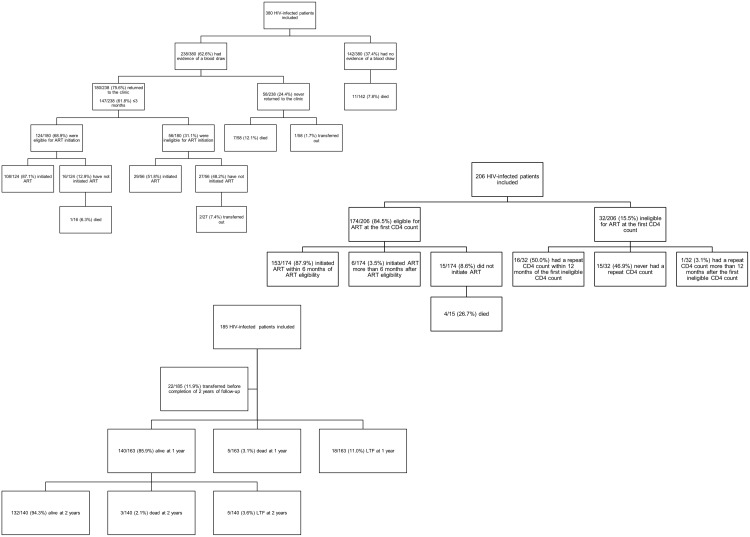
Flow Chart of Retention in Care of Three Cohorts of Patients Enrolled in Different Stages of HIV care in Johannesburg, South Africa.